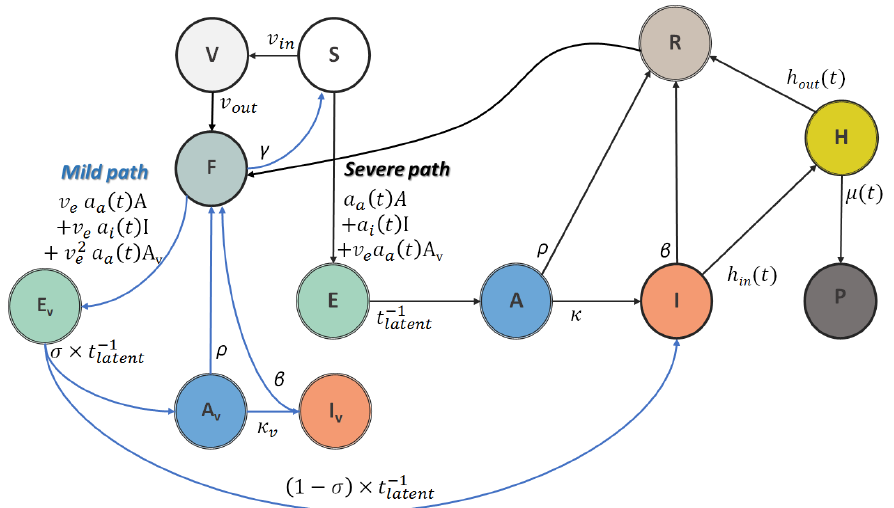
Figure 2. Schematic overview of the proposed model (SEAIR-severe/mild). Individuals in the model are classified into susceptible (S), unvaccinated exposed (E), unvaccinated asymptomatic (A), unvaccinated detected incidents (I), recovered (R), hospitalized (H), perished (P), vaccinated before immunity has been reached (V), fully vaccinated (F), vaccinated exposed (Ev), vaccinated asymptomatic (Av) and vaccinated detected incidents